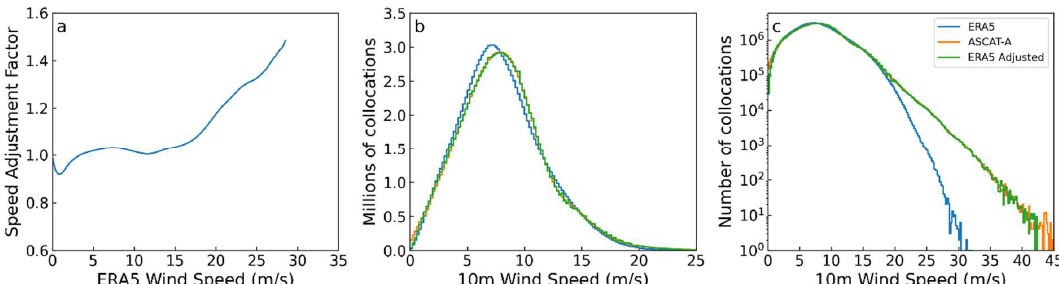
Figure 3. ( a ) Multiplicative wind speed adjustment factor derived by analyzing ERA5/ASCAT-A collocations for 2015. ( b ) Global histograms of the 10 m equivalent neutral wind speed for ERA5, ASCAT-A, and ERA5 Adjusted accumulated over 2015. ( c ) Same as ( b ), except plotted on a log scale. In this example, we derive a global correction for all months. The correction is fairly small at low and moderate wind speeds, but begins to increase rapidly above about 17 m/s. When the correction is applied to the unadjusted ERA5 winds (blue in panels b and c ), the resulting histogram (green in panels b and c ), is almost indistinguishable from the ASCAT-A histogram (orange in panels b and c ) for the same period, demonstrating the success of the method.